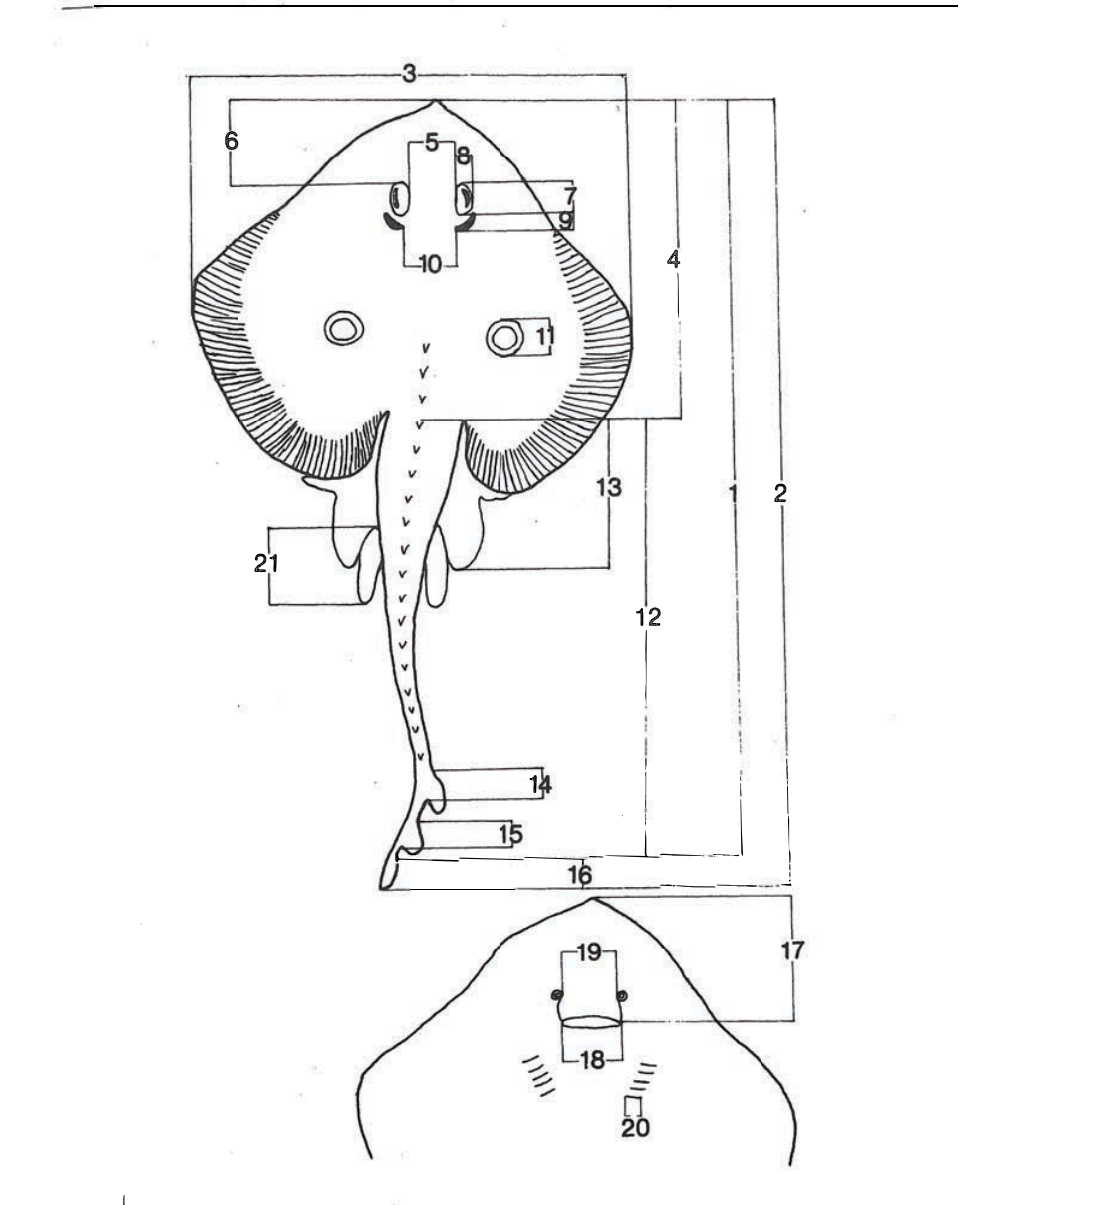
Fig. 1. Diagram of measurements of metric characters. 1 - body length (I.e.}; 2 - total length (l.t.); 3 -disc width; 4 -disc length; 5 -inter-ocular distance; 6 -snout length; 7 '--,- longitu­ dinal eye diameter; 8 ---' transverse eye diameter; 9 -spiracle length; 10 - distance between spri­ racles; 11 - vertical spot diameter; 12 - tail length; 13 -ventral (V) fin length; 14 - anterior dor­ sal fin (D 1) base length; 15 - posterior dorsal fin (D2) base length; 16 -caudal fin (C) length; 17 -rostrum length; 18 -mouth width; 19 -distance between nostrils; 20 - length of largest gill slit; 21 -clasper